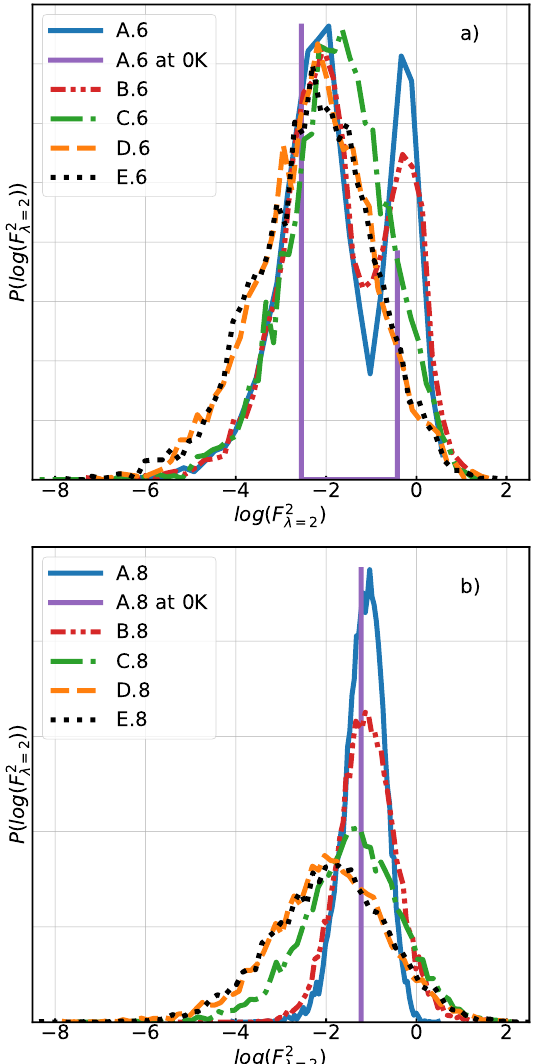
Figure 4. Comparison of distributions of the logarithm of squared forces at strain value equal to 2 (100%) for systems of ( a ) with connectivity 6 and ( b ) with connectivity 8. (Force unit is expressed in J · nm − 1 . See Table 1 for a complete description of the